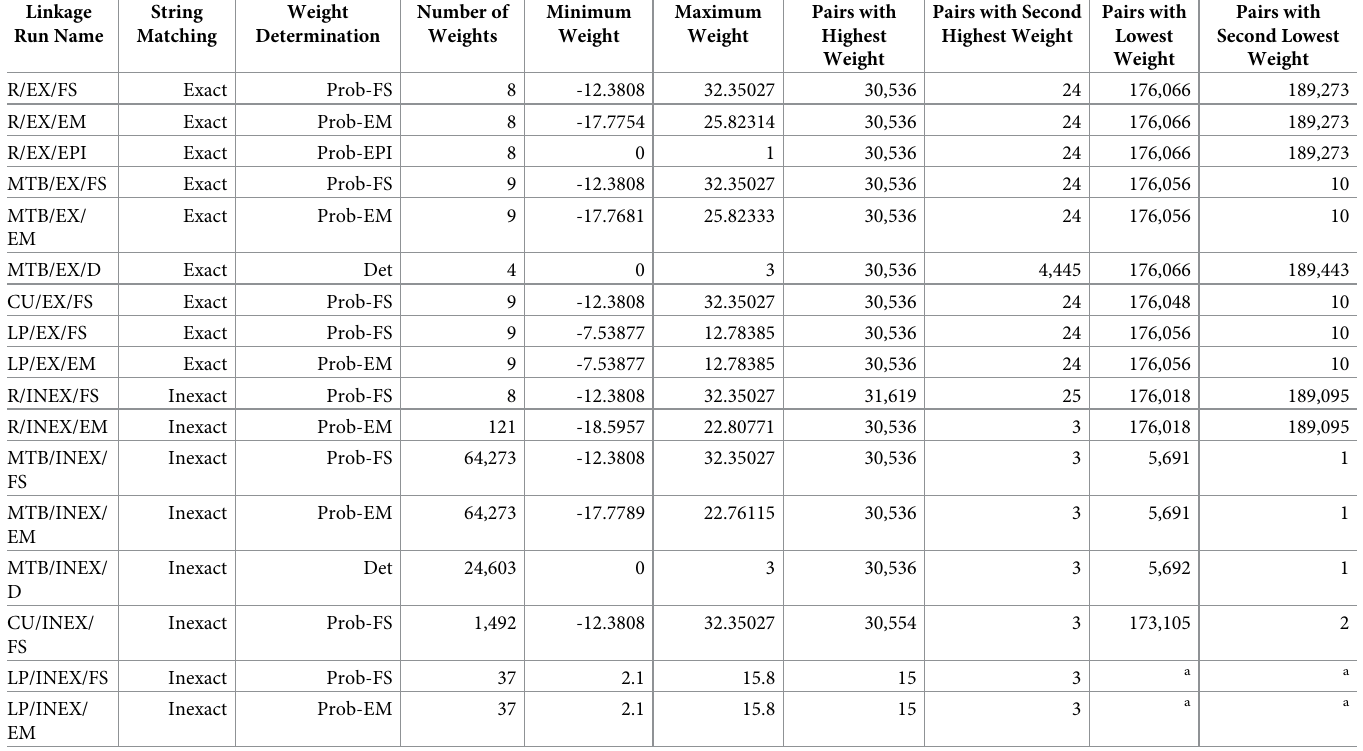
Table 2. Summary of weights produced by record linkage using DOB as the blocking variable.